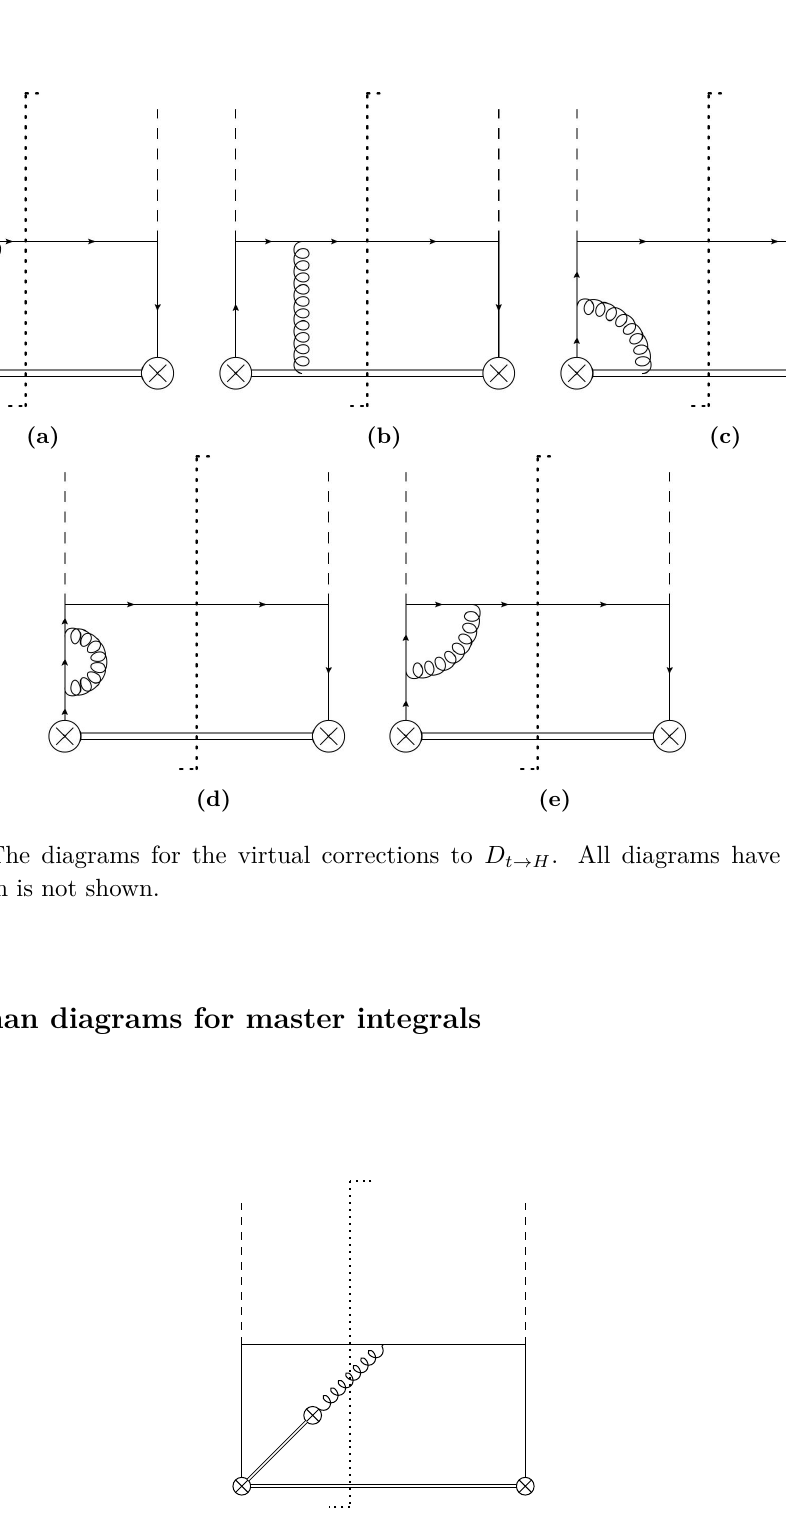
Figure 5. The scalar integral topology for the real corrections to D t → H defined in eq. (D.1). Solid lines are massive and correspond to top-quark propagators, the curly line corresponds to the gluon, dashed lines to the Higgs boson and double lines are Wilson lines. The dotted line shows the